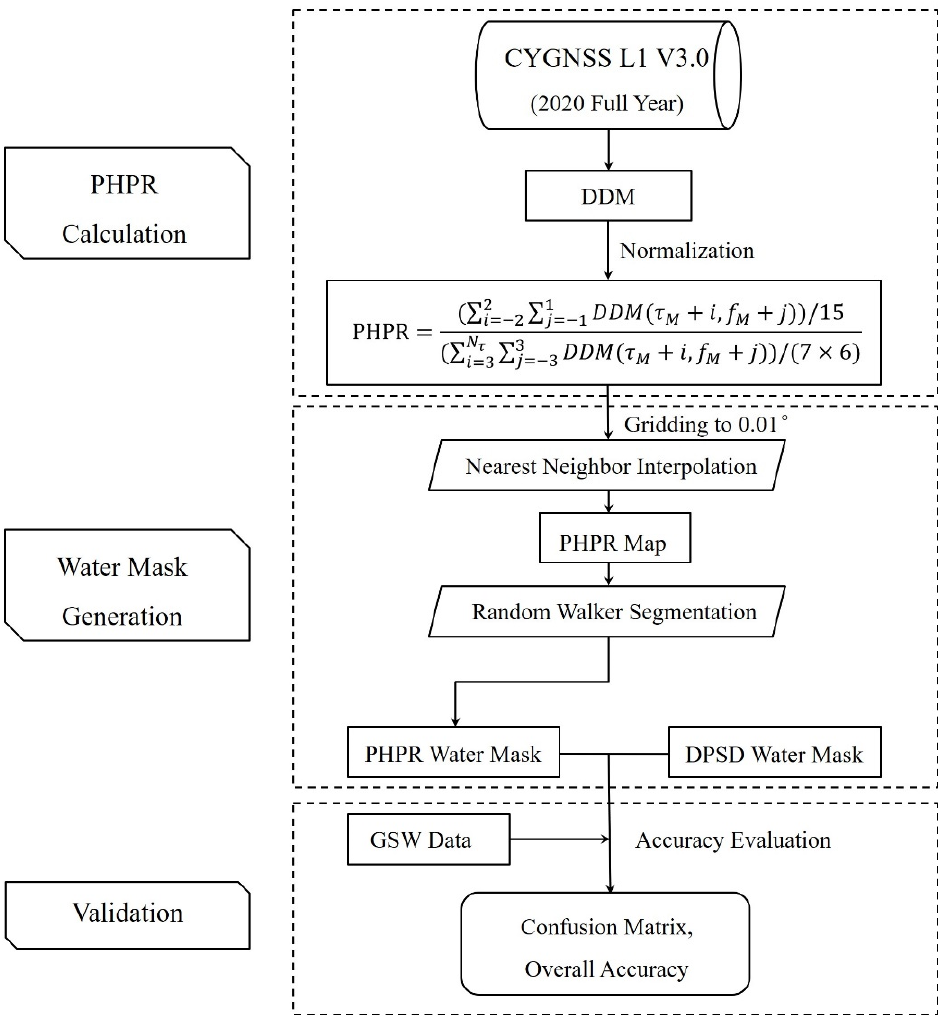
Figure 8. Flowchart of implementation of new coherence method for inland water bodies detection in this study.